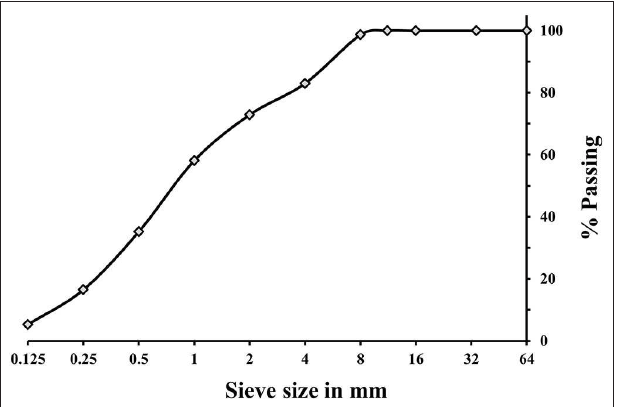
FIGURE 2 | Initial and final setting times of AAS concrete